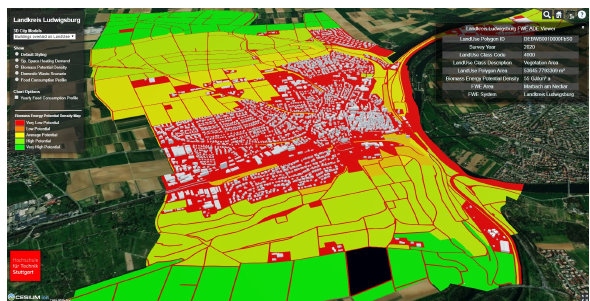
Figure 12. Marbach’s biomass potential visualisation